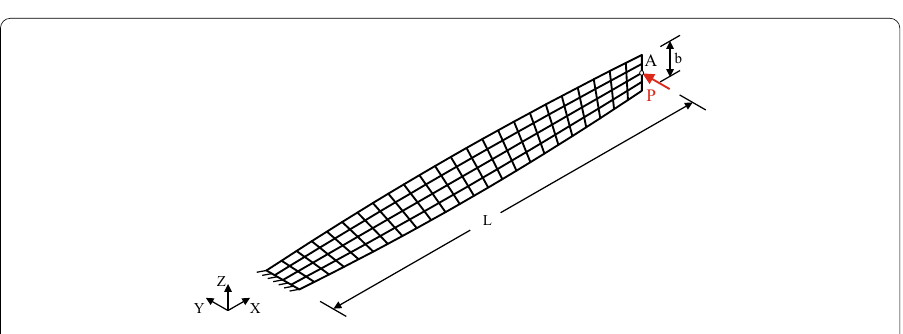
Fig. 16 Twisted beam: system and 4 × 24 regular